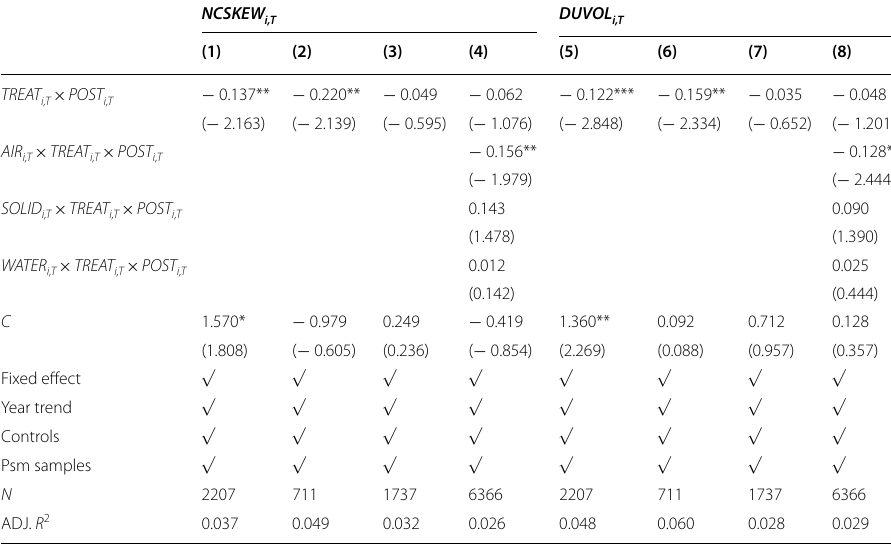
Table 15 Heterogeneity test based on